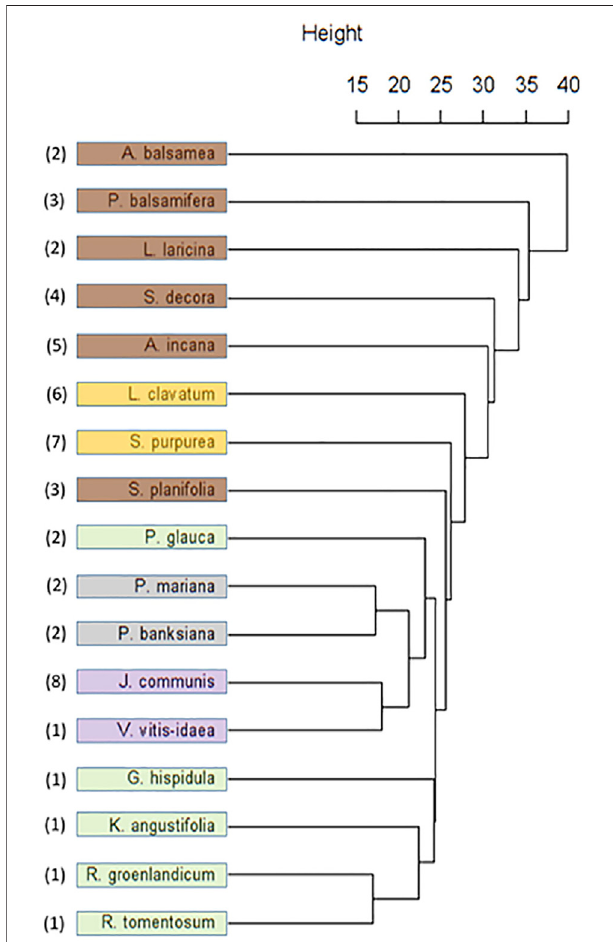
FIGURE 5 | Dendrogram resulting from Unweighted Pair Group Method with Arithmetic Mean (UPGMA) cluster analysis of Cree medicinal plant metabolomes. Species colouring indicates the plant part investigated: Brown (Bark), Yellow (Whole), Green (Leaf), Grey (Cone), Purple (Berry). Numbers indicate species family: 1 (Ericaceae), 2 (Pinaceae), 3 (Salicaceae), 4 (Rosaceae), 5 (Betulaceae), 6 (Lycopodaceae), 7 (Sarracenaceae), 8